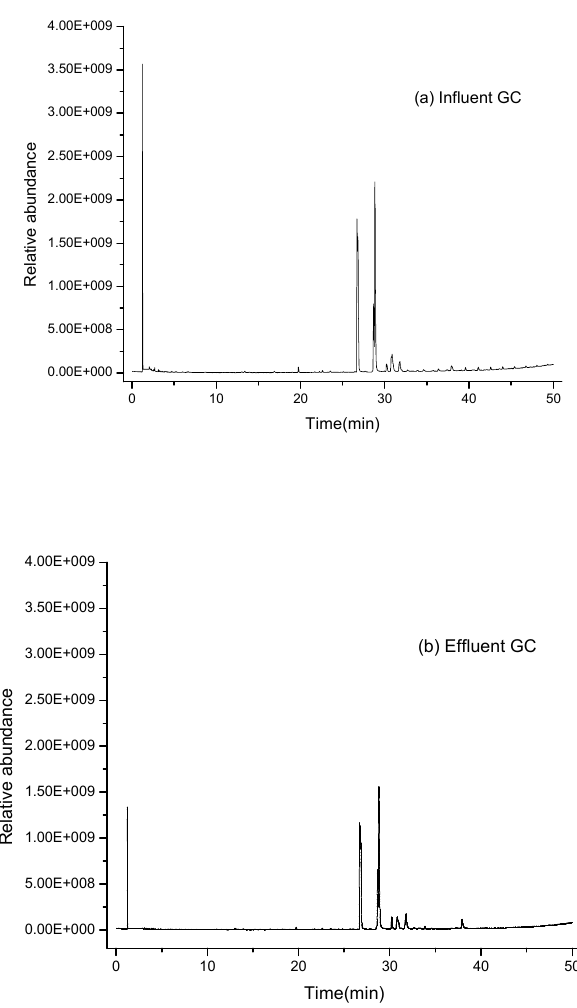
Figure 11. GC–MS chromatograms on dichloromethane extract from ( a ) influent and ( b ) effluent of the micro-electrolysis reactor. Table 4. Main component distribution of the raw oil refinery wastewater.